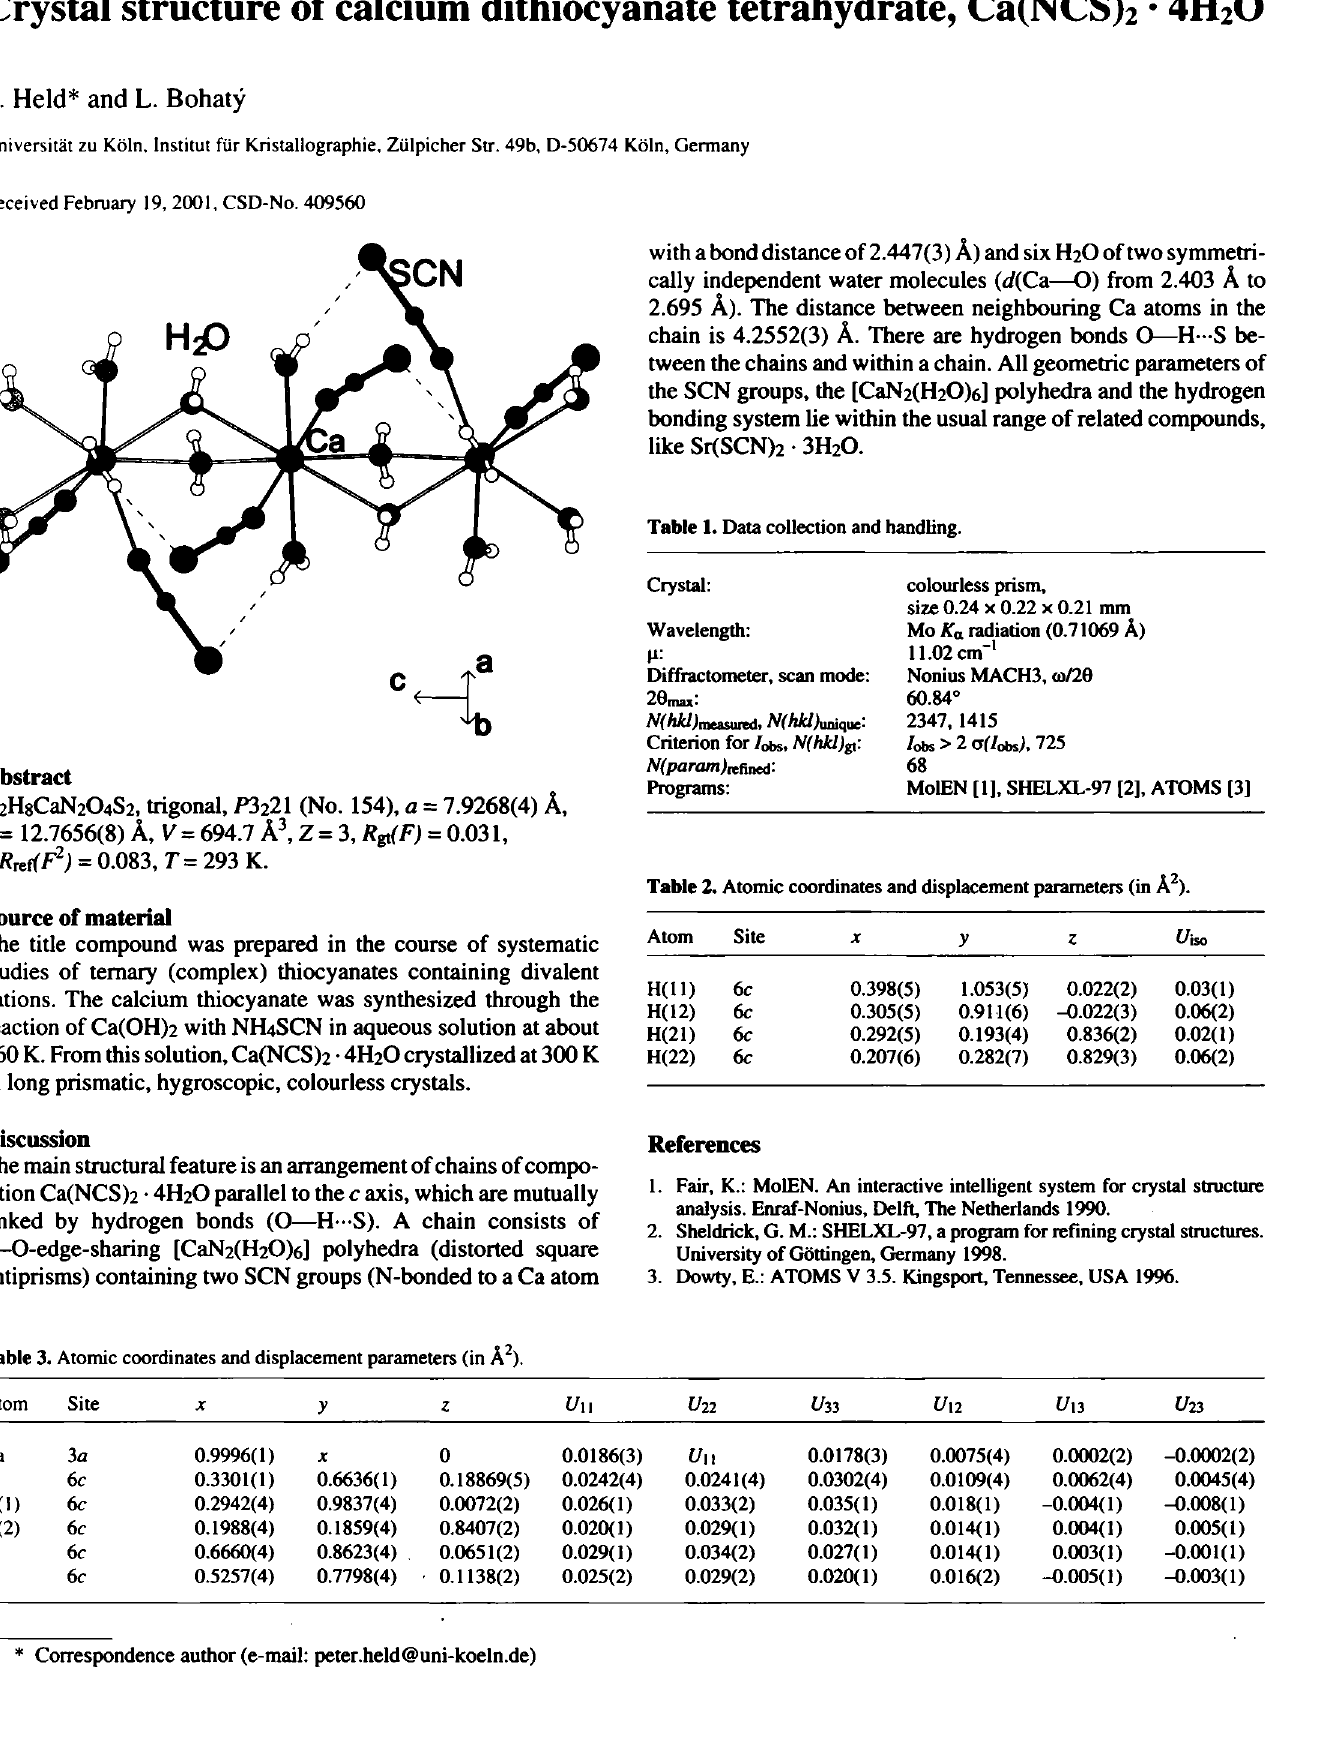
Table 3. Atomic coordinates and displacement parameters (in Ä 2